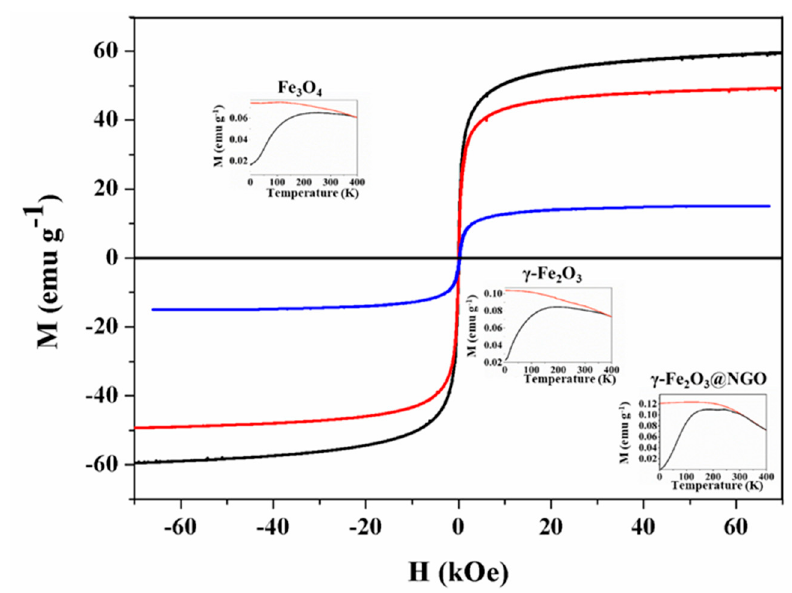
Figure 4. Hysteresis loops M(H) for Fe 3 O 4 (black) and γ -Fe 2 O 3 (red) and γ -Fe 2 O 3 @NGO (blue) nanoparticles. The insets show the Zero-field cooled (black) and field-cooled (orange) magnetization curves for Fe 3 O 4 , γ -Fe 2 O 3 , and γ -Fe 2 O 3 @NGO, taken with H FC = 100 Oe.